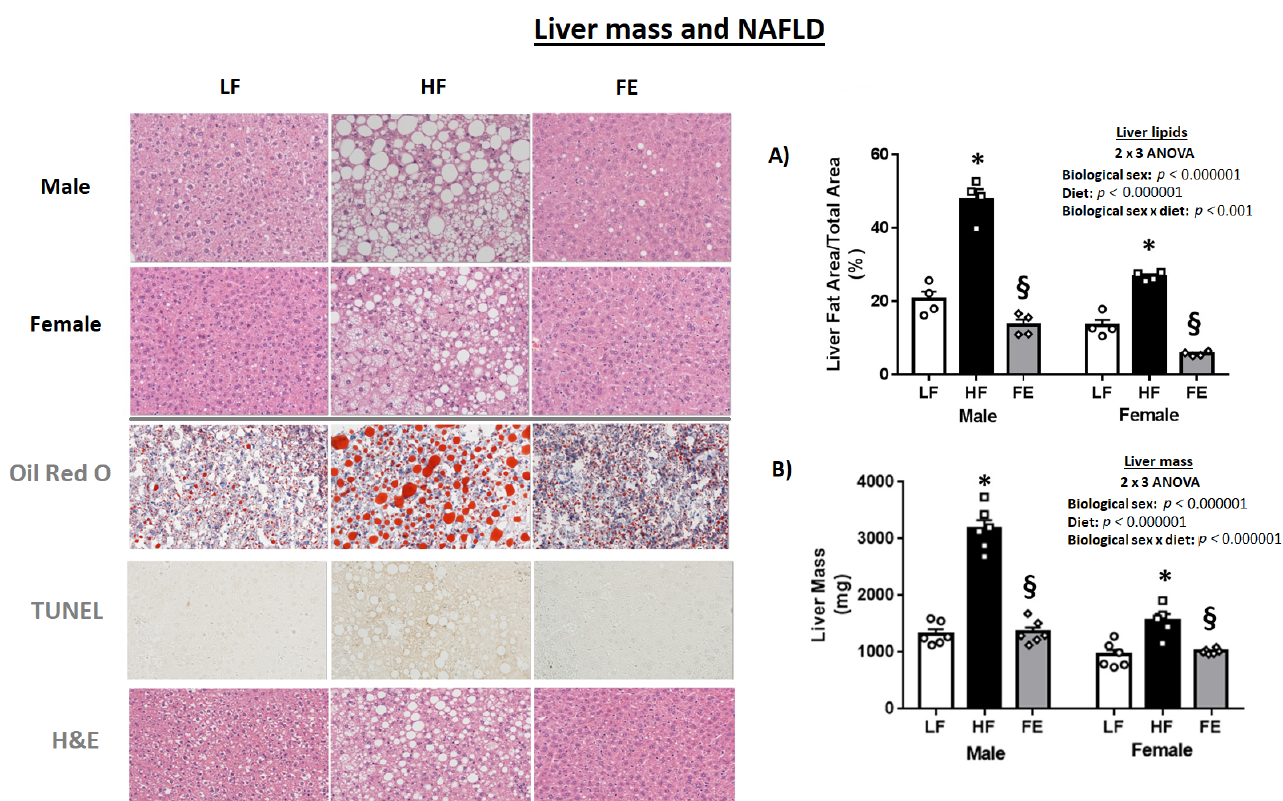
Figure 6. Effects of the ‘Fertility Enhancer’ supplement on NAFLD and liver mass in Western Diet- fed C57BL/6J mice. ( A ) Liver lipid droplet area. ( B ) Liver mass. * Significantly different from LF ( p ≤ 0.05). § Significantly different from HF ( p ≤ 0.05).